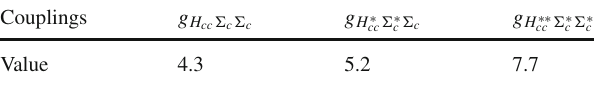
Table 3 Couplings of (cid:2) ( ∗ ) c (cid:2) ( ∗ ) c molecules to their components obtained with a cutoff of (cid:3) = 0.86 GeV